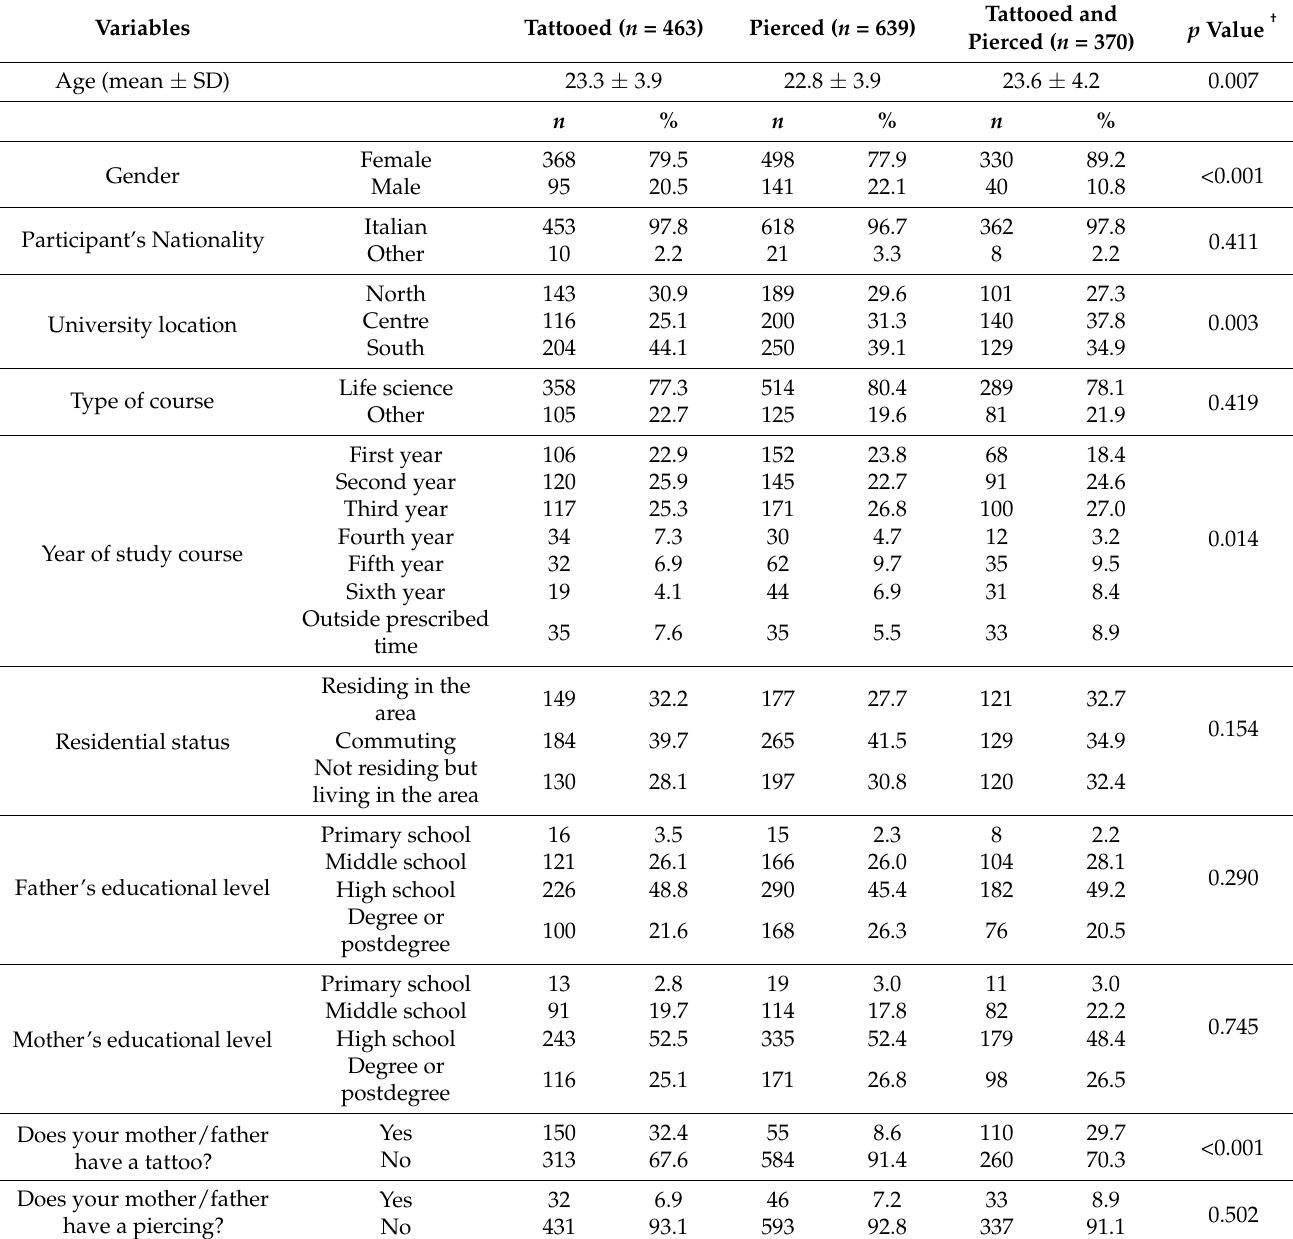
Table 1. Sociodemographic characteristics of participants ( n = 1472) grouped for type of body art gotten.